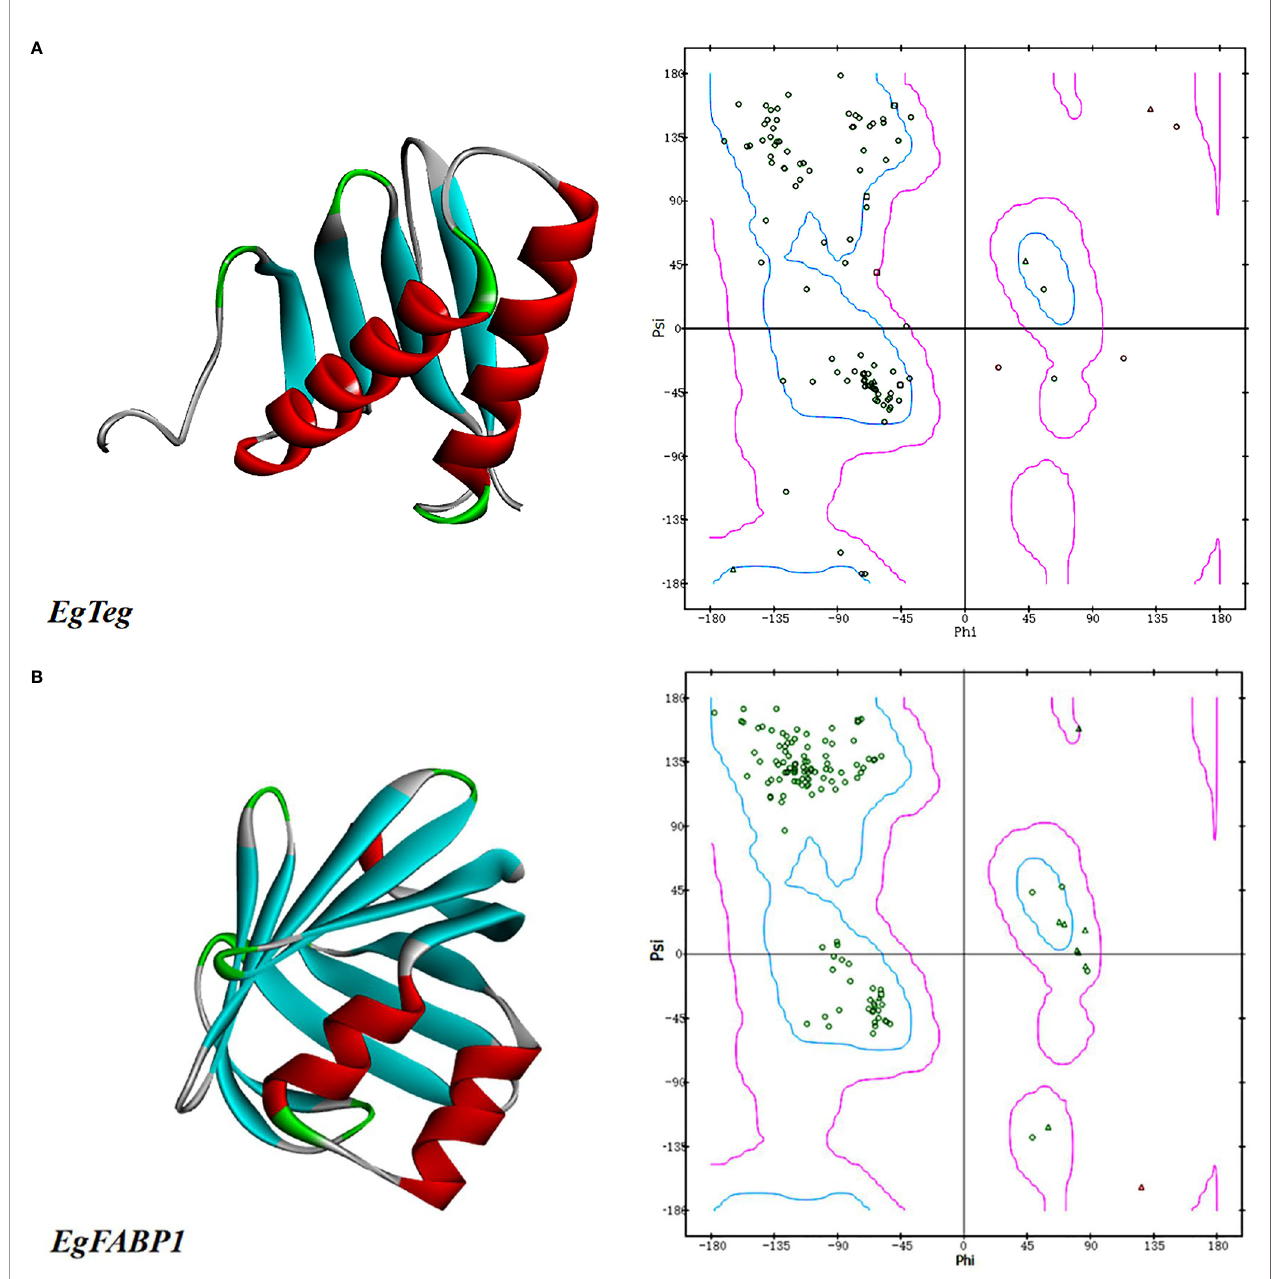
FIGURE 1 | (A) The predicted tertiary structures of Protein EgTeg. (B) The predicted tertiary structures of Protein EgFABP1. The left part is tertiary structure of protein and the display style is Solid ribbon. The right part is Ramachandran plot, Phi represents the rotation angle of C-N bond on the left side of a -carbon in a peptide unit and Psi represents the rotation angle of C-C bond on the right side of a -carbon. In this Ramachandran plot, the area inside the blue coil is completely allowed, the area inside the purple coil is allowed and the area outside the purple coil is not allowed. When the scatter in the blue coil and the purple coil exceeds 90%, the tertiary structure of the model conforms to the rule of stereochemistry. (For understanding the reference color in remark of the fi gure clearly, please readers refer to the web version of this